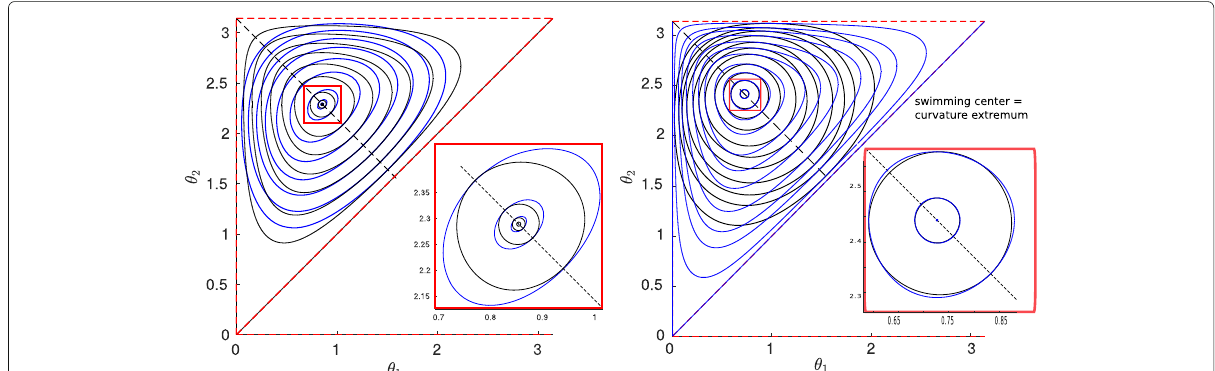
Fig. 17 Level-sets of the swimming curvature (blue) and family of simple strokes (black) for the Euclidean metric (left) and the mechanical cost (right)